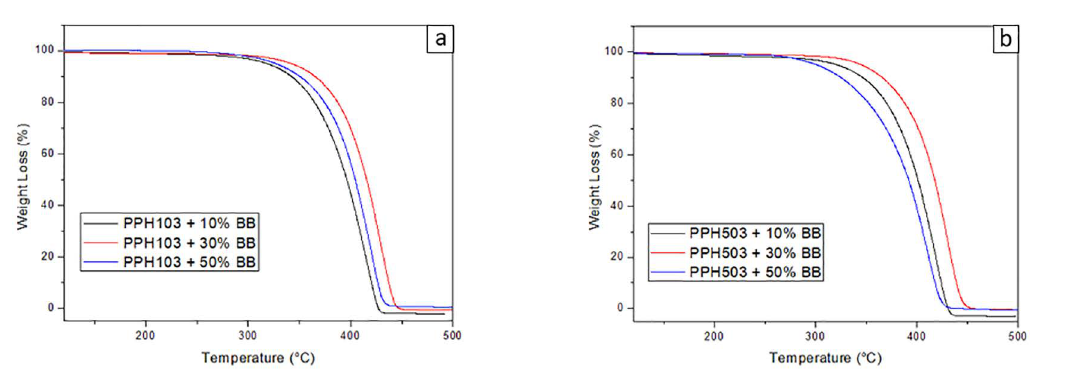
Figure 2. TG curves of PP H103 (a) and PP H503 (b) compounds with 10, 30 and 50% of R